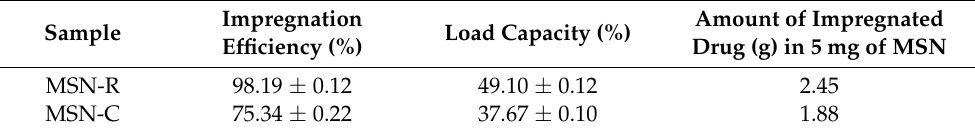
Table 1. The values of impregnation efficiency, load capacity and amount of incorporated lycopene for both nanoparticles.